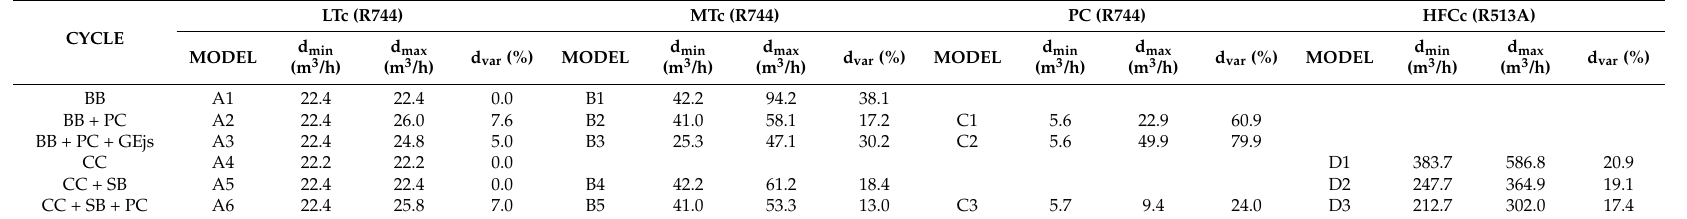
Table 3. Compressor displacements and their variation over all the range of environment temperatures